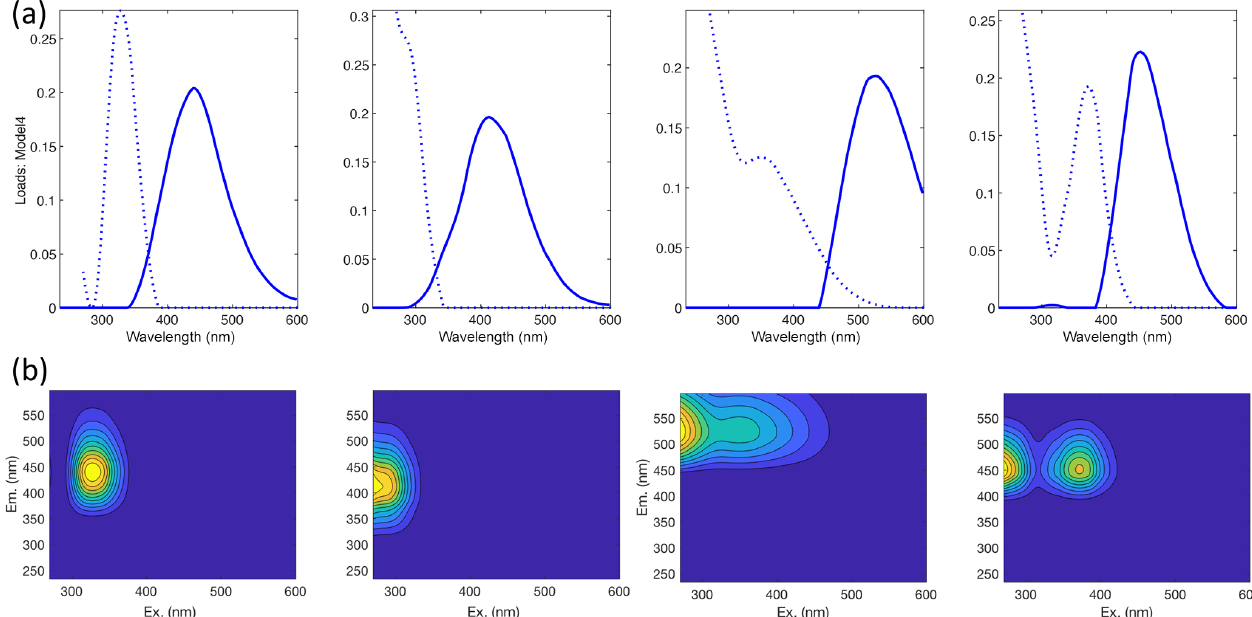
Figure 1. (a) Spectral loadings and (b) contour plots of PARAFAC components (one–four; left to right) modeled from EEMs of SRNOM PPL extract photodegradation time series. In the top row, the dashed lines represent excitation spectra, and the solid lines show emission spectra. The full data set of all degradation time series EEMs was projected onto this model.